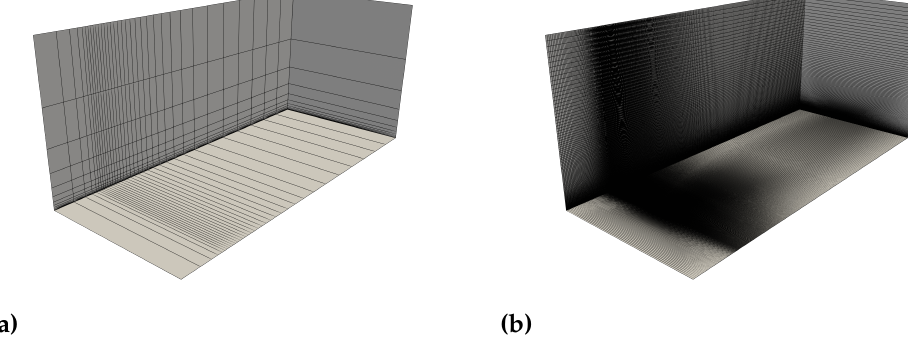
Figure 9. Sample mesh for the flat plate case: ( a ) 35